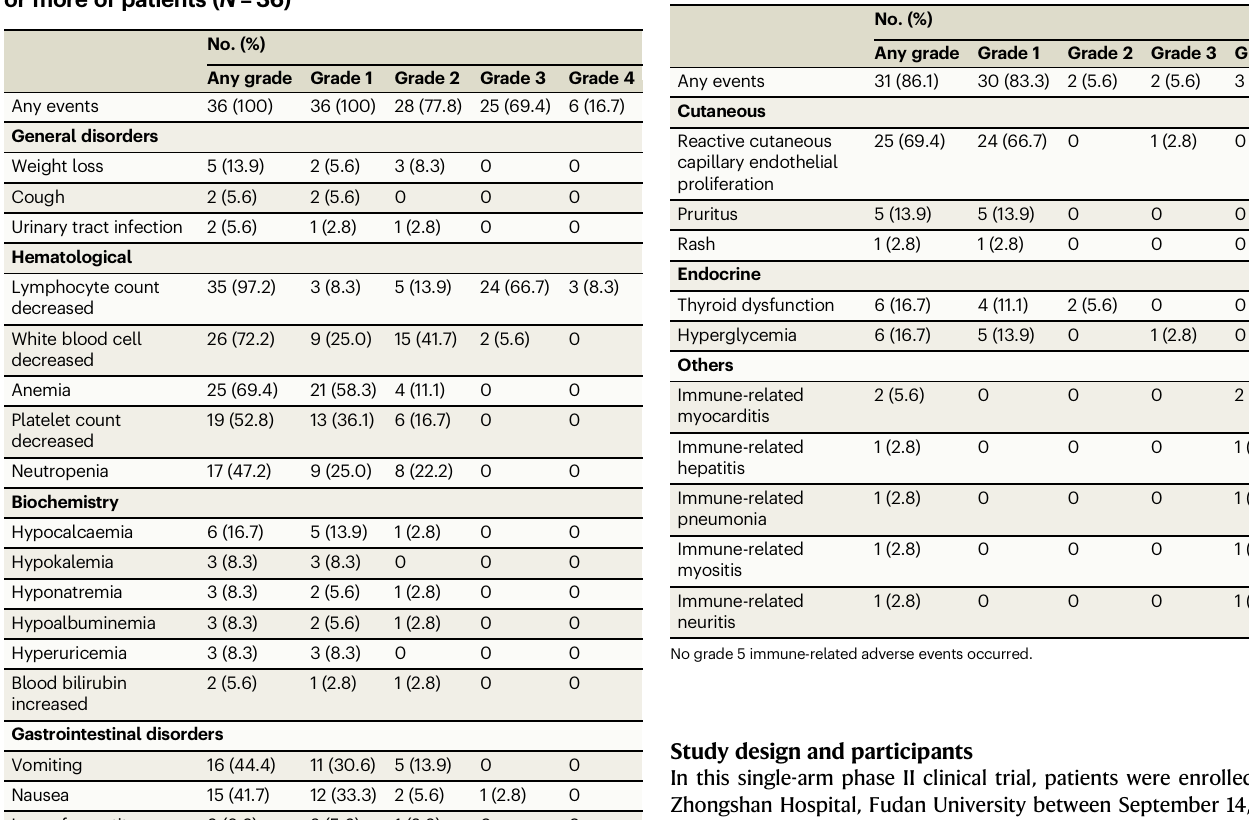
Table 4 | All immune-related adverse events ( N =